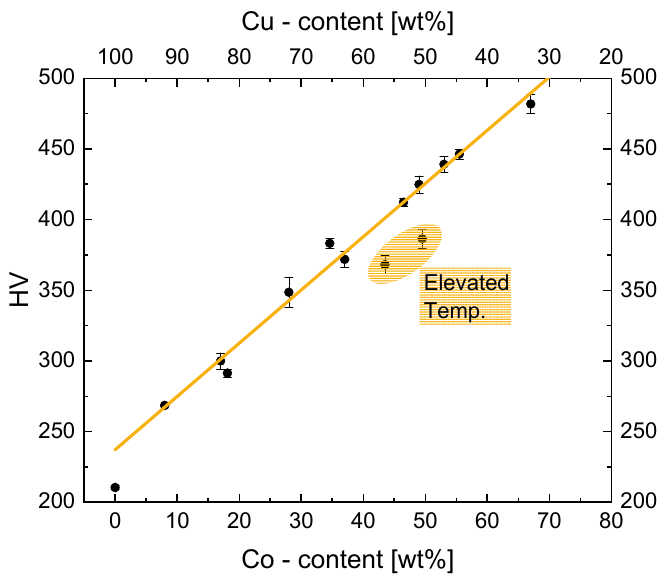
Figure 2. Hardness HV as a function of Cu-Co-content, showing a linear trend for room temperature deformed samples. The highlighted measurements were made on samples Cu 55 Co 45 (large HPT, elevated temperature) and Cu 49 Co 51 (small HPT, 200 °C) Hardness values from samples presented in reference [40] are included. The linear fit between 10 wt % and 70 wt % Co, representing a simple rule of mixture, is a guide for the eye.